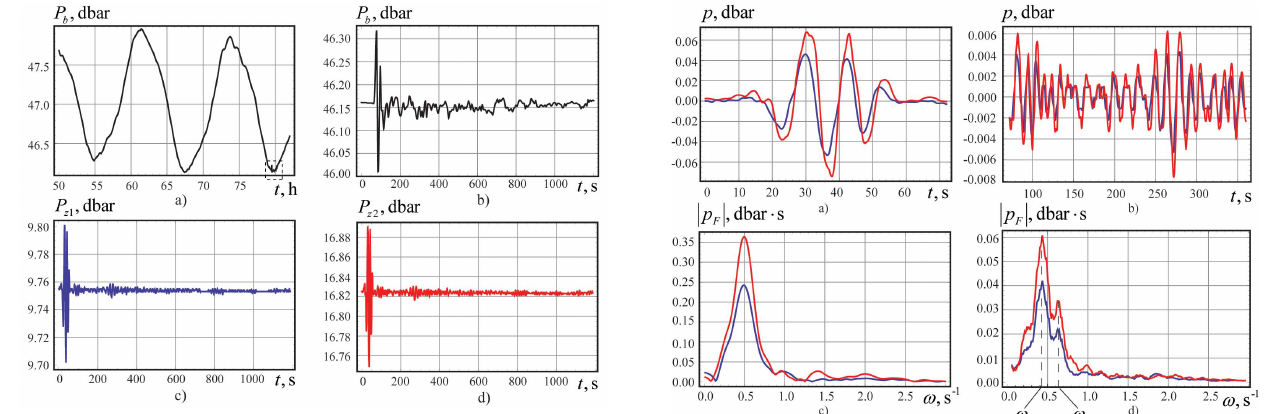
Fig. 6. Water pressure perturbations by the leading pulse (a) and wave tails (b) and absolute values of their Fourier transforms (c, d) . Blue and red lines correspond to gauges 1 and 2,